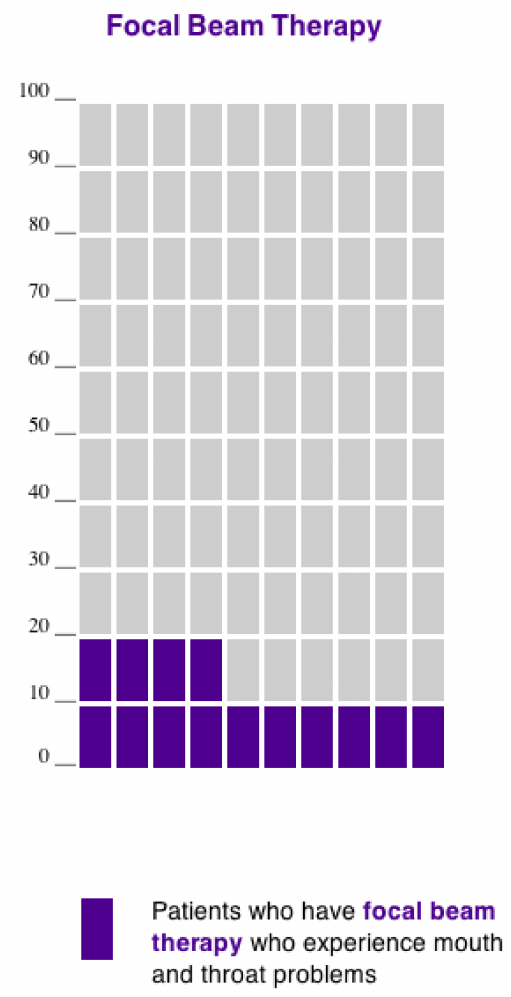
Figure 1. Icon arrays (version V1: static grouped) displaying the risk of mouth and throat problems for both hypothetical